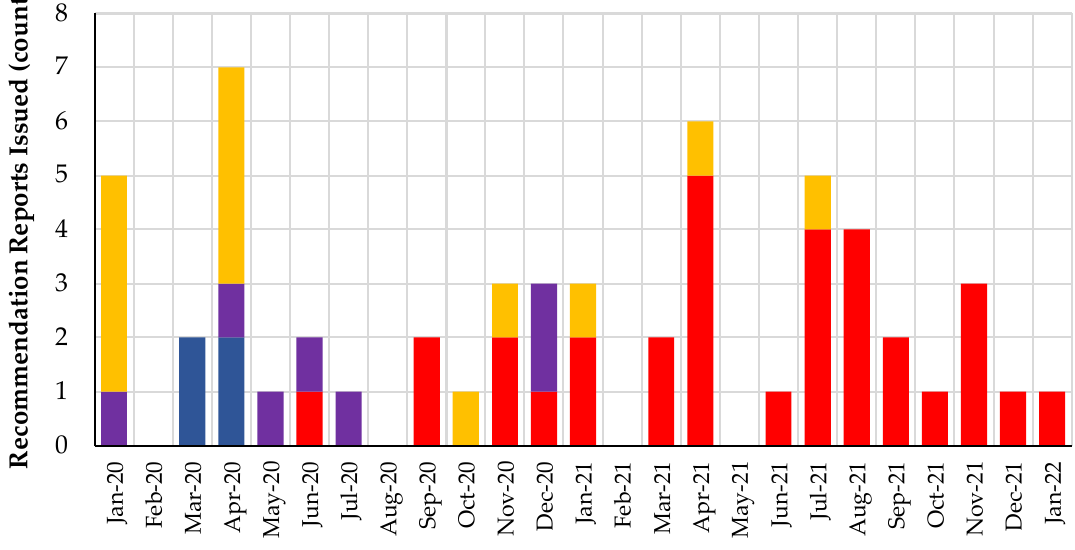
Figure 2. Cost per QALY threshold values referenced in CADTH’s Recommendation Reports for